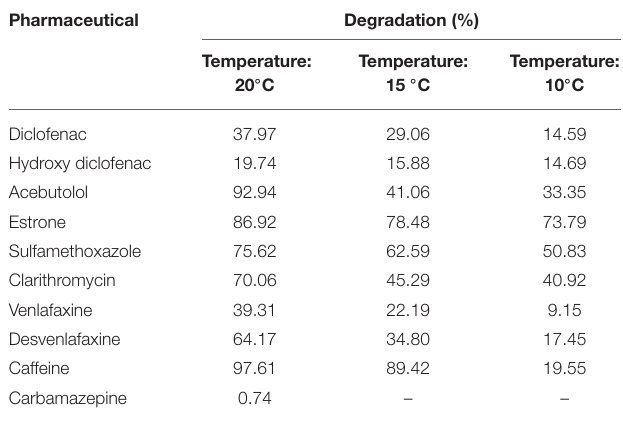
TABLE 2 | Removal of pharmaceuticals in SMBR at varying operating temperature.